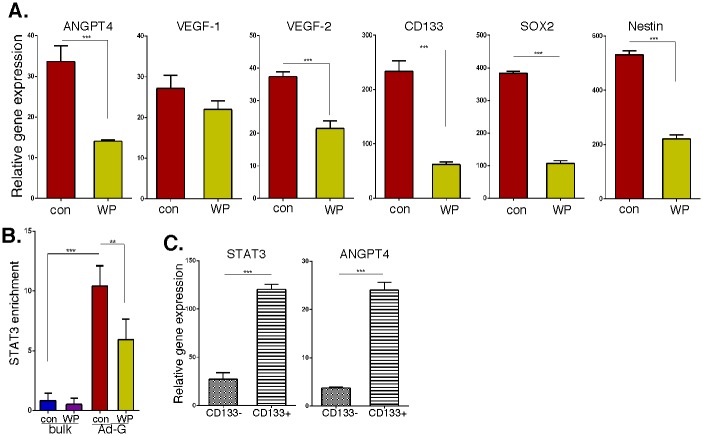
The STAT3/ANGPTL4 pathway in GSCs.A. RNA was prepared from GBM6 Ad-GSCs treated with WP1066 (50 μM) for 6 hrs, and the expression of ANGPTL4, VEGF-R1, VEGF-R2, CD133, SOX2 and Nestin was quantified by qPCR and normalized to actin expression (n = 3). B. ChIP-enriched STAT3 binding to the ANPTL4 promoter was analyzed by qPCR and normalized to input DNA, followed by subtraction of nonspecific binding determined by control IgG. C. Single cells isolated from bulk GBM6 tumor cells were incubated with anti-CD133 antibody, and data acquisition and analysis was performed on a three-laser LSR (Becton-Dickinson) flow cytometer using CellQuest software. RNA isolated from CD133+ and CD133- cells was subjected to qPCR as indicated and normalized to actin expression. Error bars, S.D. * p < 0.05, ** p < 0.01, *** p < 0.001.